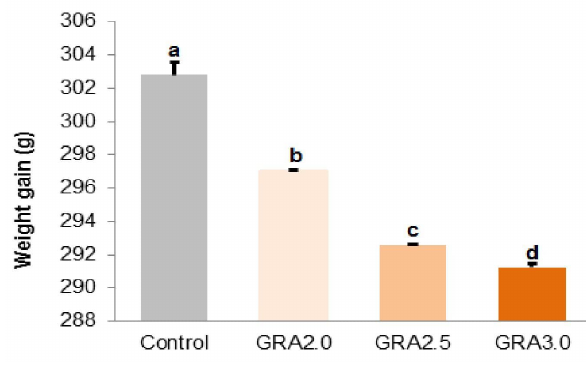
Figure 5 : Animal weight at the end of the 42-day study. Data are presented as means ± standard deviation (S.D.) for average weight in treated (GRA:Granadilla doses of 2.0; 2.5 and 3.0 g/L) and non- treated animals (control) based on one-way ANOVA followed by Tukey test ( n =4). Lower-case letters represent significant differences in treatments ( p ≤0.05).